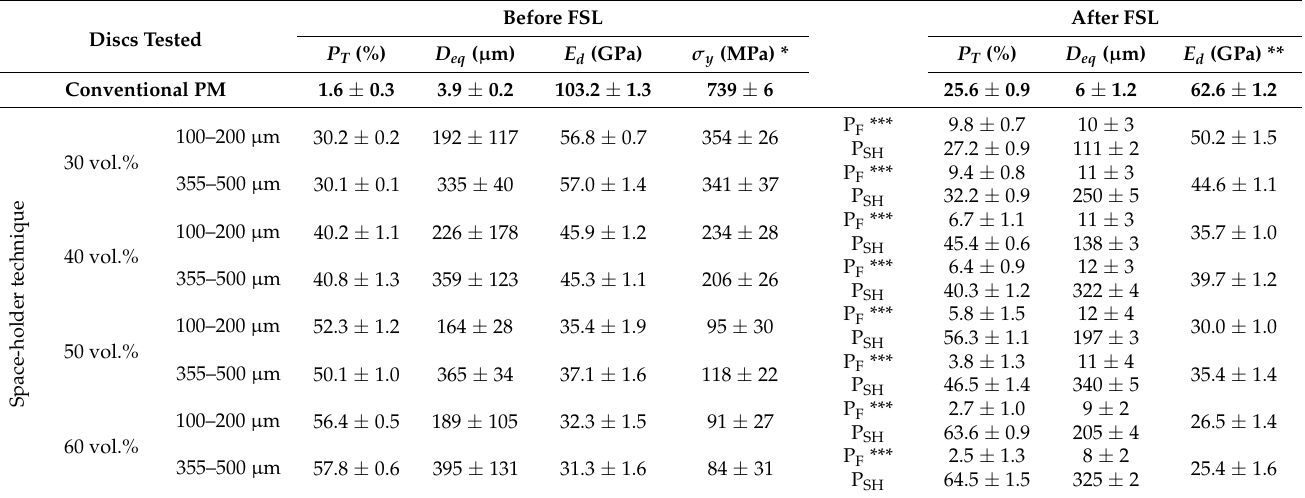
* The values of the yield stress estimated before and after femtosecond laser treatment were similar because the static mechanical behavior does not depend on the additional micro-porosity generated on the surface of the samples by the laser. ** The estimated E d values after FSL corresponded to the surface of the samples (influences the additional porosity due to surface treatment). *** Micro-porosity generated with the femtosecond laser relative to the effective area of the titanium matrix between the pores.